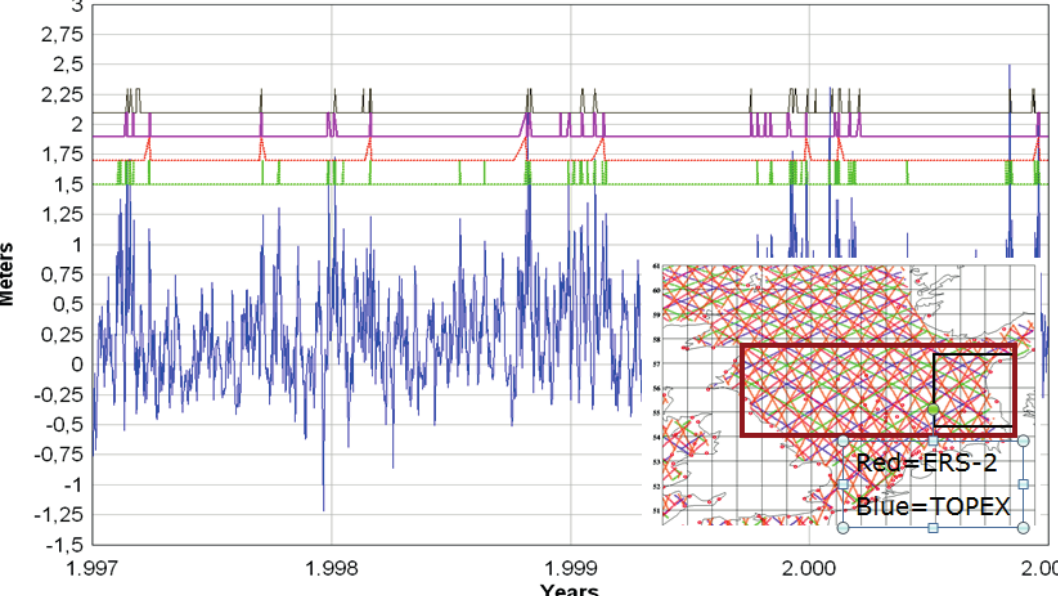
Fig. 2 Tide gauge recordings (in blue) at Hvidesande for the 1997–2001 period in metres. The inserted picture shows altimetry tracks in the North Sea from TOPEX/POSEIDON and ERS-1/2. Episodes when the sea level at the Hvidesande tide-gauge was higher than 2 times the standard deviation are marked in green. High water events captured by the TOPEX/POSEIDON satellite within the black box are marked in red. High water events captured by the TOPEX/POSEIDON satellite within the red box, are marked with purple. High waver events recorded by the ERS-2 satellite within the red box are marked with